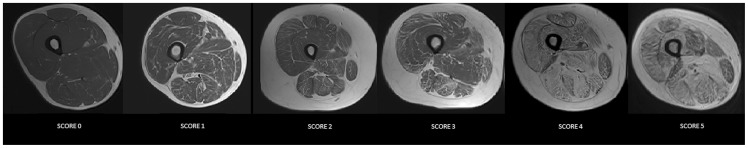
Modified Mercuri's scores, showing progressive grades of muscular fatty replacement.